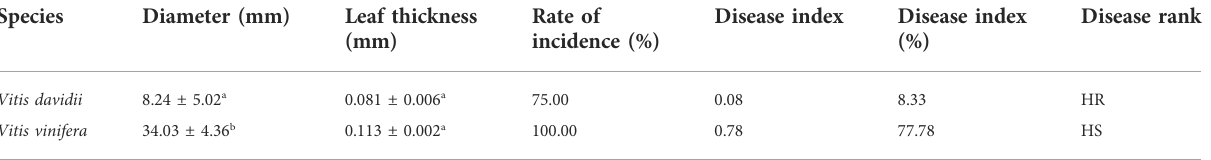
TABLE 1 Comparison of two Vitis species after Coniella diplodiella inoculation.